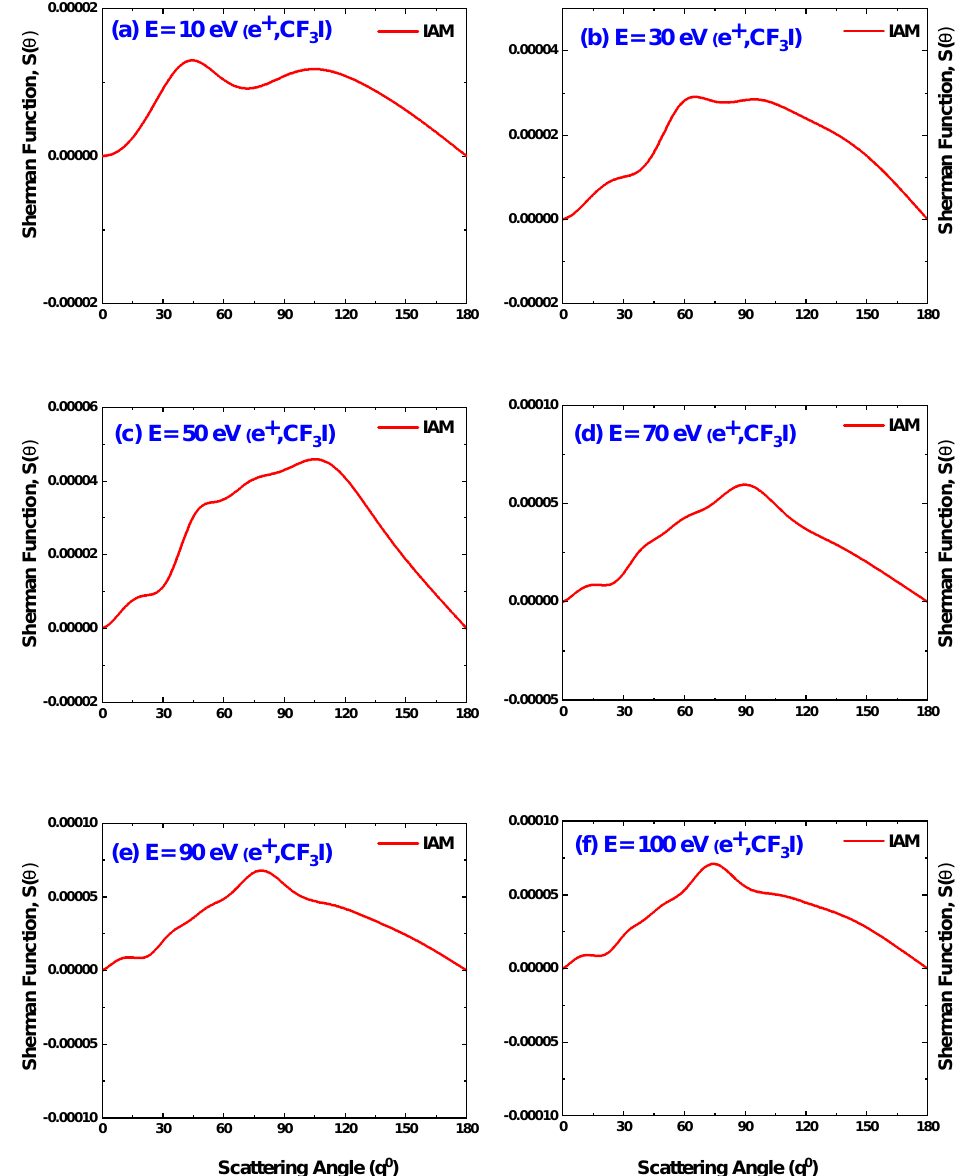
Figure 7. Sherman function for the elastic scattering of positrons from CF 3 I at incident energies 10, 30, 50, 70, 90, and 100 eV. Theoretical works: